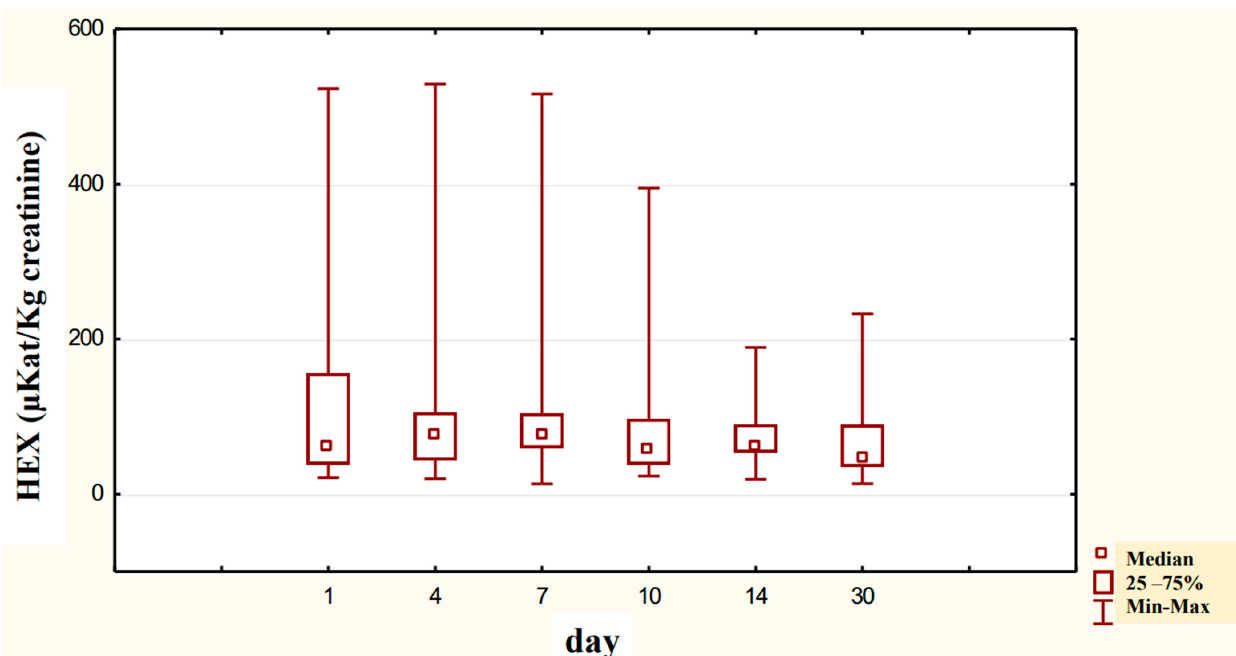
Figure 8. Variability over time of specific urinary HEX activity ( μ Kat/kg creatinine) of alcohol-dependent patients treated with neoglandin (N).